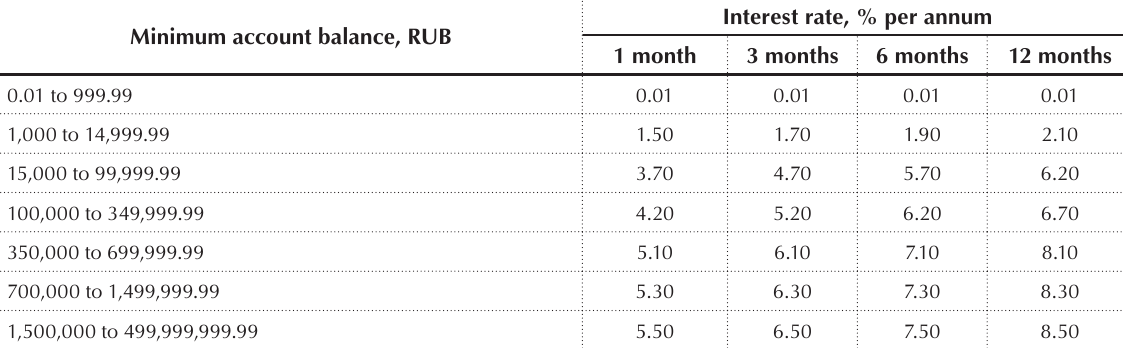
Table 8. (cid:47)(cid:374)(cid:410)(cid:286)(cid:396)(cid:286)(cid:400)(cid:410)(cid:3)(cid:396)(cid:258)(cid:410)(cid:286)(cid:400)(cid:3)(cid:381)(cid:374)(cid:3)(cid:115)(cid:100)(cid:17)(cid:1006)(cid:1008)(cid:3)(cid:400)(cid:258)(cid:448)(cid:349)(cid:374)(cid:336)(cid:400)(cid:3)(cid:258)(cid:272)(cid:272)(cid:381)(cid:437)(cid:374)(cid:410) Minimum account balance,